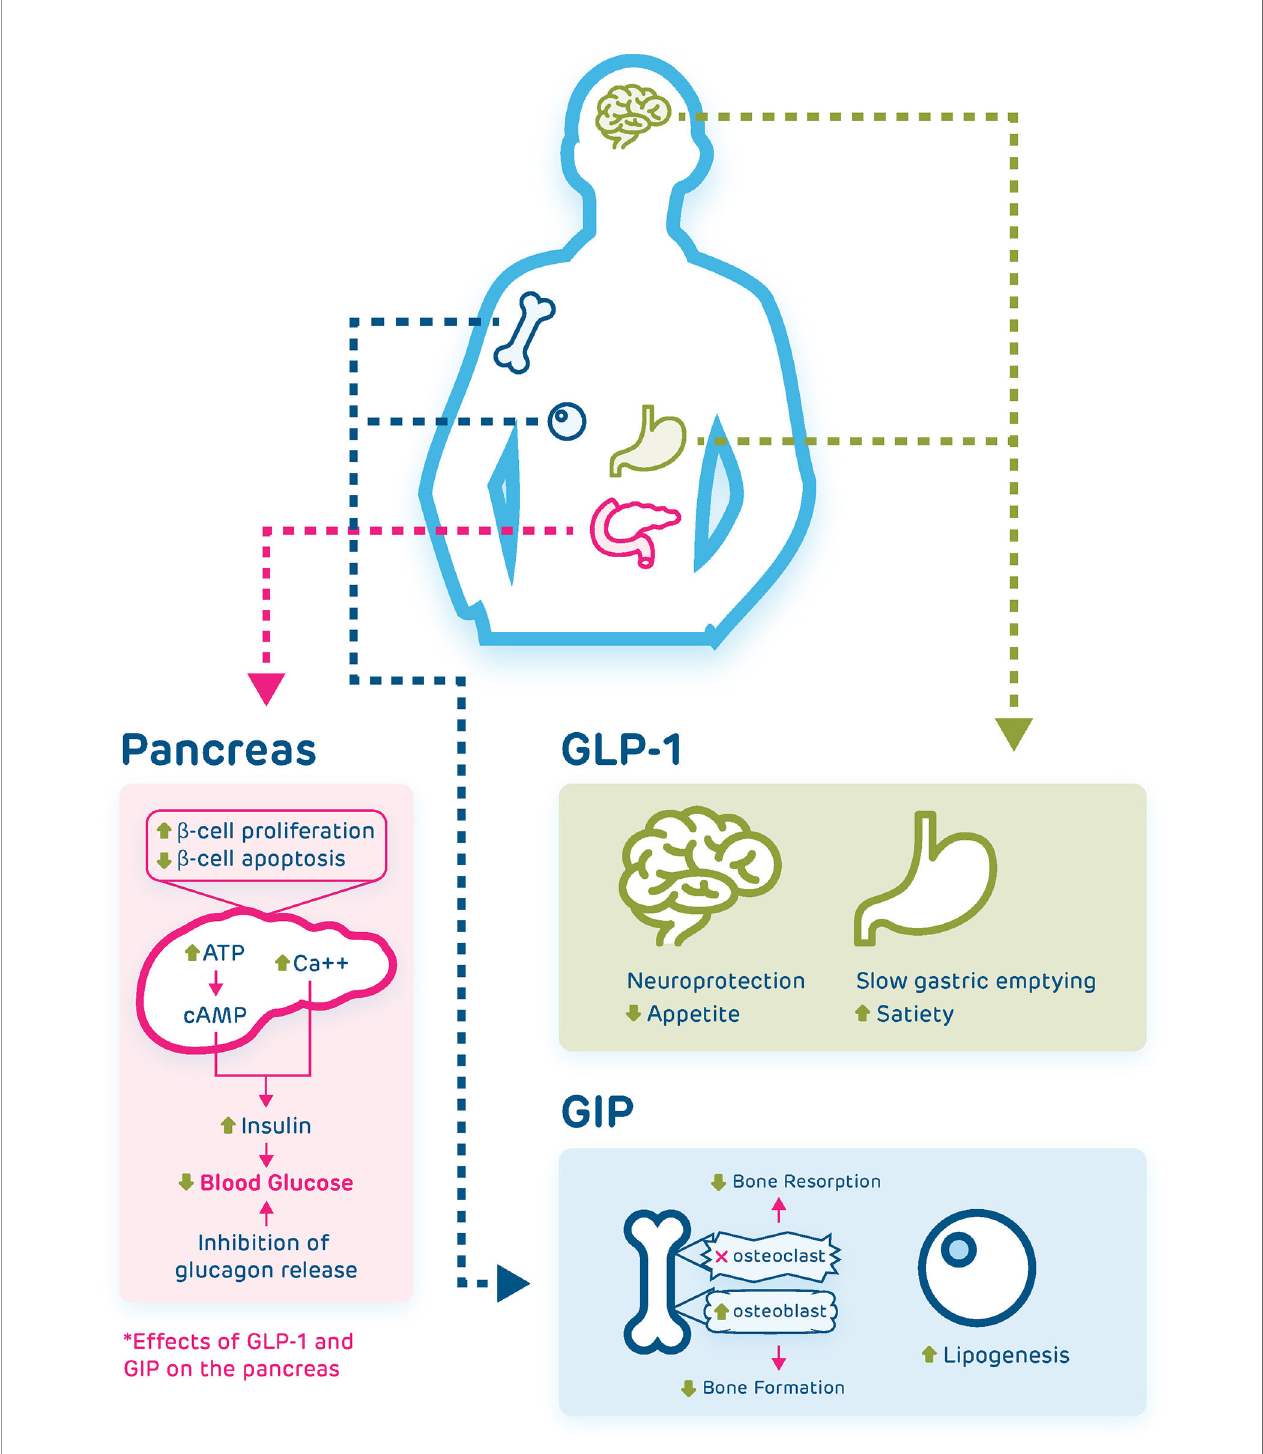
FIGURE 1 | Pancreatic and extrapancreatic effects of GLP-1 and GIP. Both incretins act on the beta cells of the pancreas and lead to reduction of blood glucose via several mechanisms, including increasing intracellular calcium, induction of a cAMP mediated pathway, and inhibition of glucagon release. GLP-1 also acts on the brain where it has neuroprotective effects and suppresses appetite, and on the stomach where it leads to slowed gastric emptying and increased satiety. GIP acts on the bone where it inhibits osteoclast action and promotes osteoblast action, leading to increased bone formation, and acts on fat cells to induce lipogenesis.